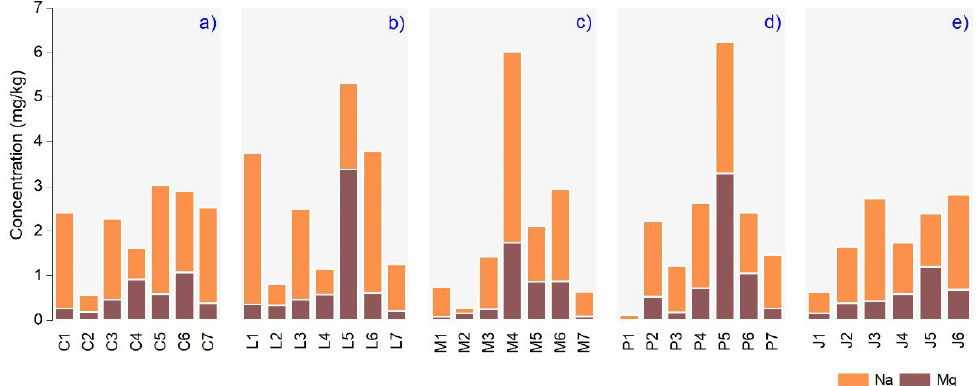
Figure 3. The macronutrients elemental levels (mg/kg) measured in the samples analyzed: ( a ) Thymus vulgaris L., ( b ) Lavandula augustifolia Mill., ( c ) Mentha × pipperita L., ( d ) Pinus sylvestris L., ( e ) Juniperus communis L.